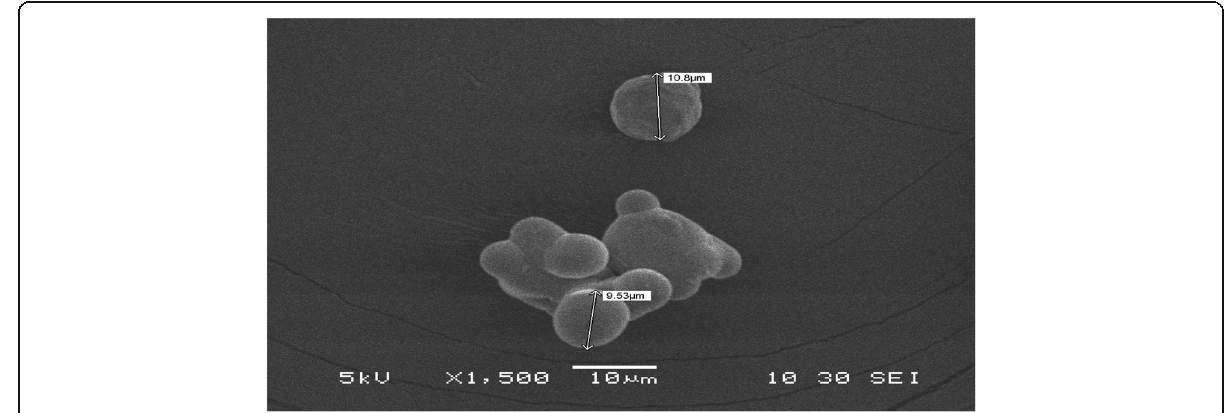
Fig. 2 SEM micrographs of microcapsules containing E. rivorum S22C produced under spray-drying